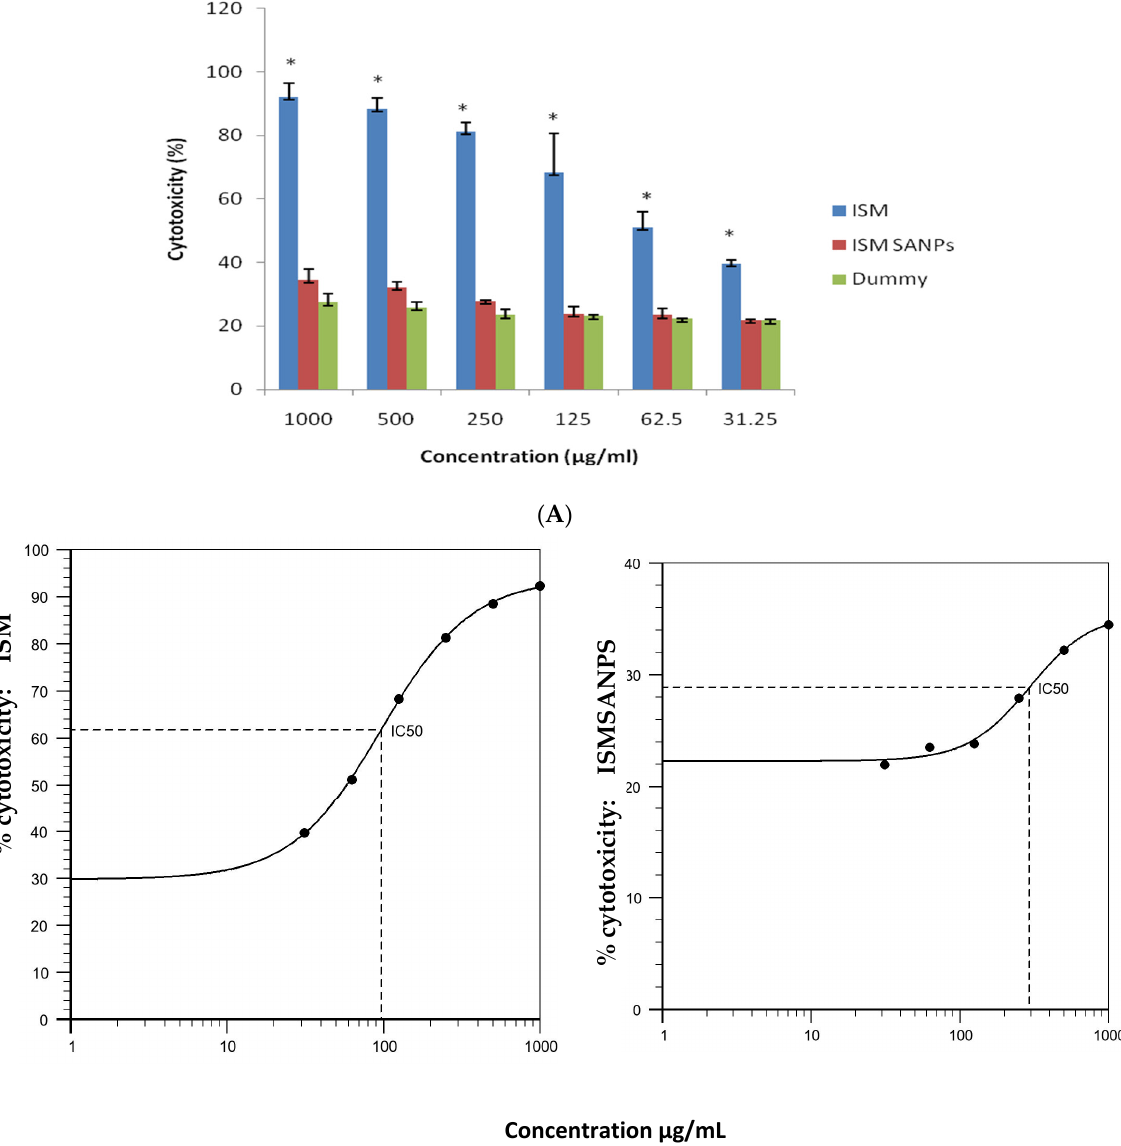
Figure 3. ( A ) Cytotoxicity in response to different concentrations of ISM, ISM SANPs, and dummy NPs is expressed relative to untreated Vero cells, as determined by resazurin assay. Error bars show the standard deviation. The variation in toxic effects amongst ISM and ISM SANPs/controls was statistically significant ( p < 0.01) shown by *. ( B ) IC 50 determined for ISM and ISM SANPs. IC 50 was calculated using a Hill four-parameter logistic regression model. Table 1. The difference between ARP sites of ISM amd ISM SANPS treatments.